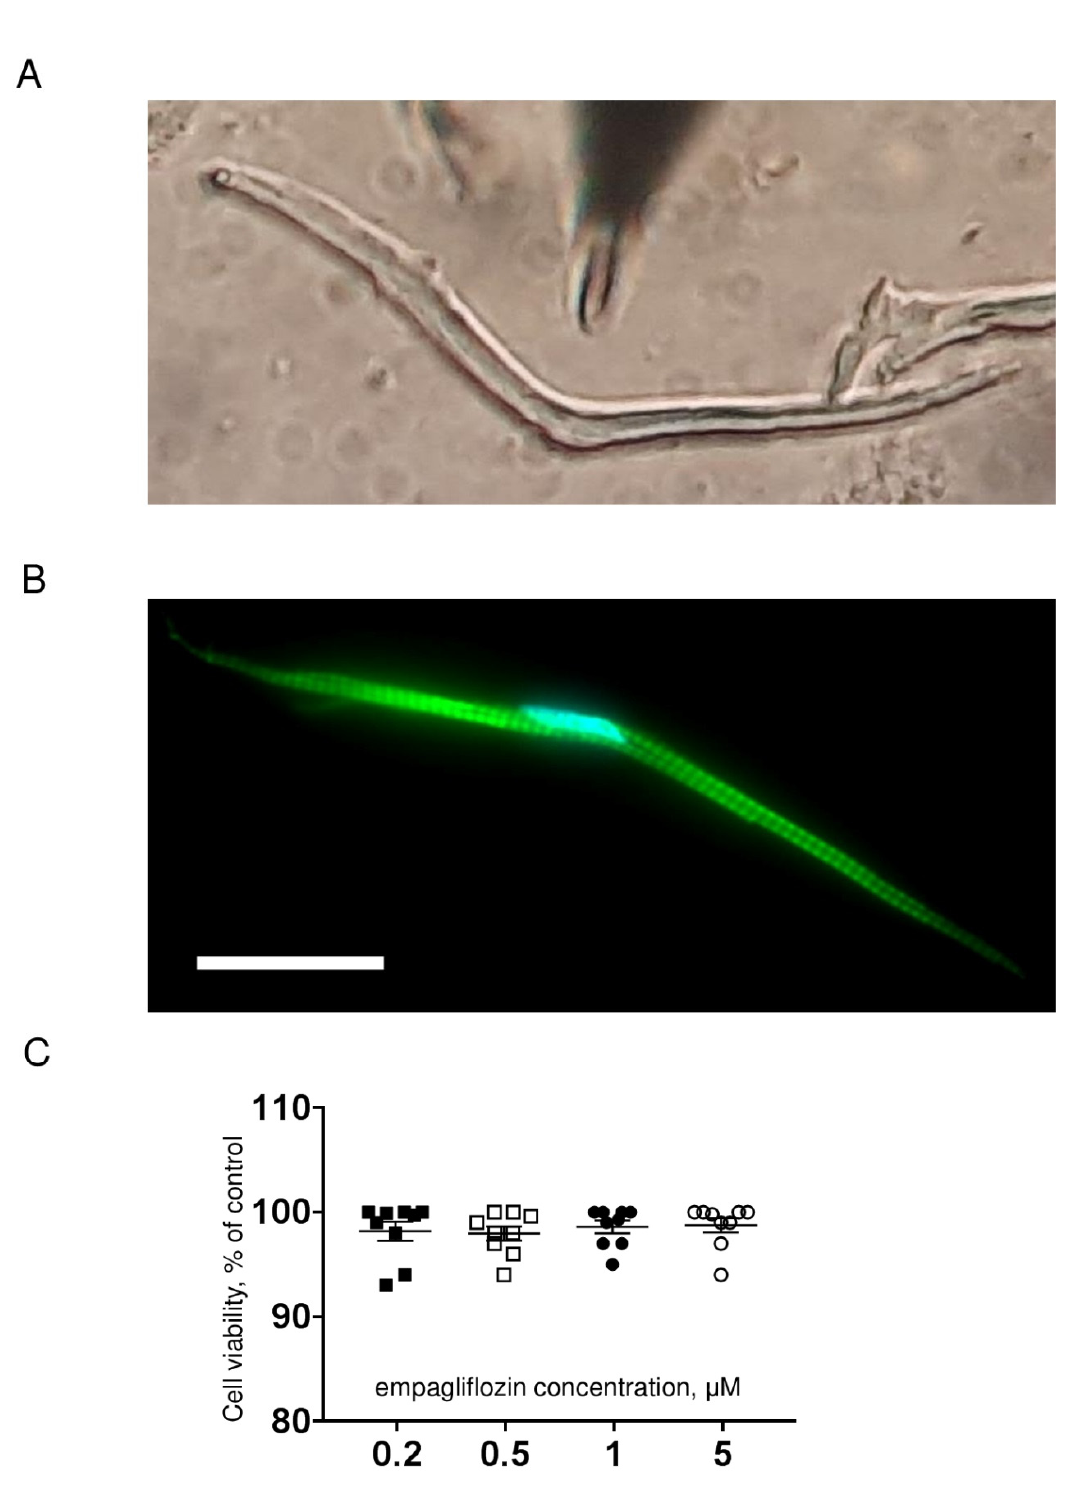
Figure 1. ( A ) Representative image of an isolated zebrafish ventricular cardiomyocyte used for patch clamp experiments. Magnification: 40 × . ( B ) Representative image of actin filaments (green) staining using phalloidin in zebrafish cardiomyocytes. Nucleus (blue) was visualized with DAPI. Scale bar is 20 µ m. ( C ) Grouped data on MTT test for cardiomyocytes treated with empagliflozin. Data are expressed as % of value obtained for untreated cells.